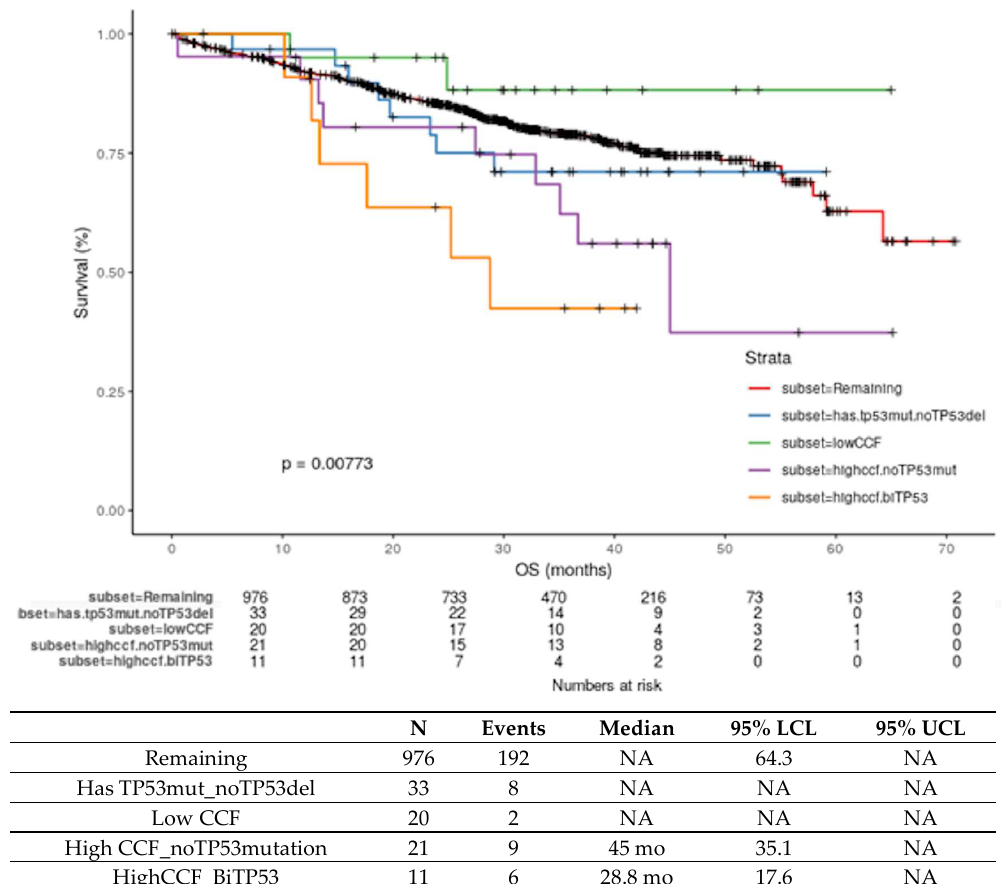
Figure 2. Kaplan-Meier survival curve for updated OS in months from the MGP dataset ( n = 1,061) showing patients with (a) CCF > 0.55 + mutation of TP53 (highccf.biTP53, orange line), (b) CCF > 0.55 without a mutation in TP53 (highccf.noTP53mut, purple line), (c) CCF < 0.55 (lowCCF, green line), (d) TP53 mutation without a deletion of 17p (has.TP53mut.noTP53del, blue line), and remaining patients who did not fall into any of these groups (red line). The number in each group, number of events, median OS, and lower and upper 95% lower / upper confidence intervals (LCL, UCL) are provided in the table.